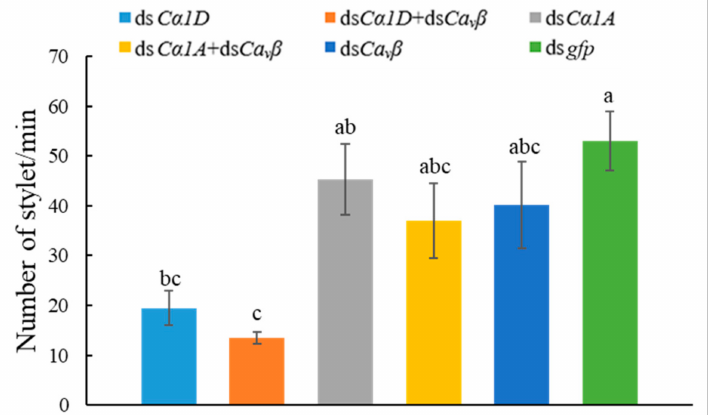
Figure 8. Silencing of Ca v β or HVA Ca v α 1 and co-silencing of Ca v β and HVA Ca v α 1 affected the stylet thrusting of D. destructor . Nematodes that were treated with gfp dsRNA were used as controls. Different lowercase letters indicate a significant difference at the level of p < 0.05, as tested by Duncan’s new complex difference method.